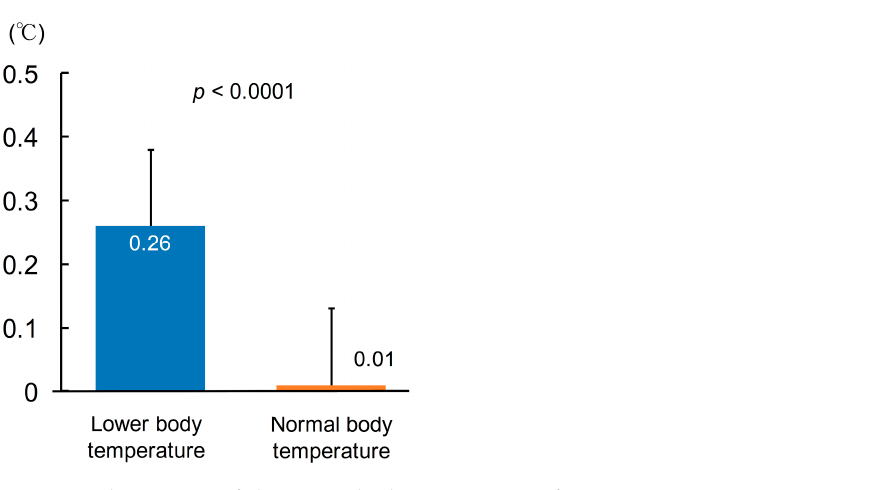
When participants were classified according to status of activity of daily living, inci- dence of increase in metabolic rate (56% vs. 44% vs. 39%, p = 0.36), skeletal muscle mass (40% vs. 44% vs. 35%, p = 0.82), body fat mass (66% vs. 50% vs. 48%, p = 0.25), and body temperature (80% vs. 78% vs. 96%, p = 0.19) were no significant differences among partic- ipants with independent outdoor walking, independent indoor walking, and indoor walking with assistance, respectively. 3.6. Variable Related to the Rise in Body Temperature When multivariate logistic regression analysis was performed, increase in skeletal muscle mass after exercise emerged as an independent variable related to the rise in body temperature (odds ratio: 4.73, 95% confidence interval: 1.29–17.26, p = 0.02, Table 2). Table 2. Multivariate factors related to the rise in body temperature. Odds Ratio